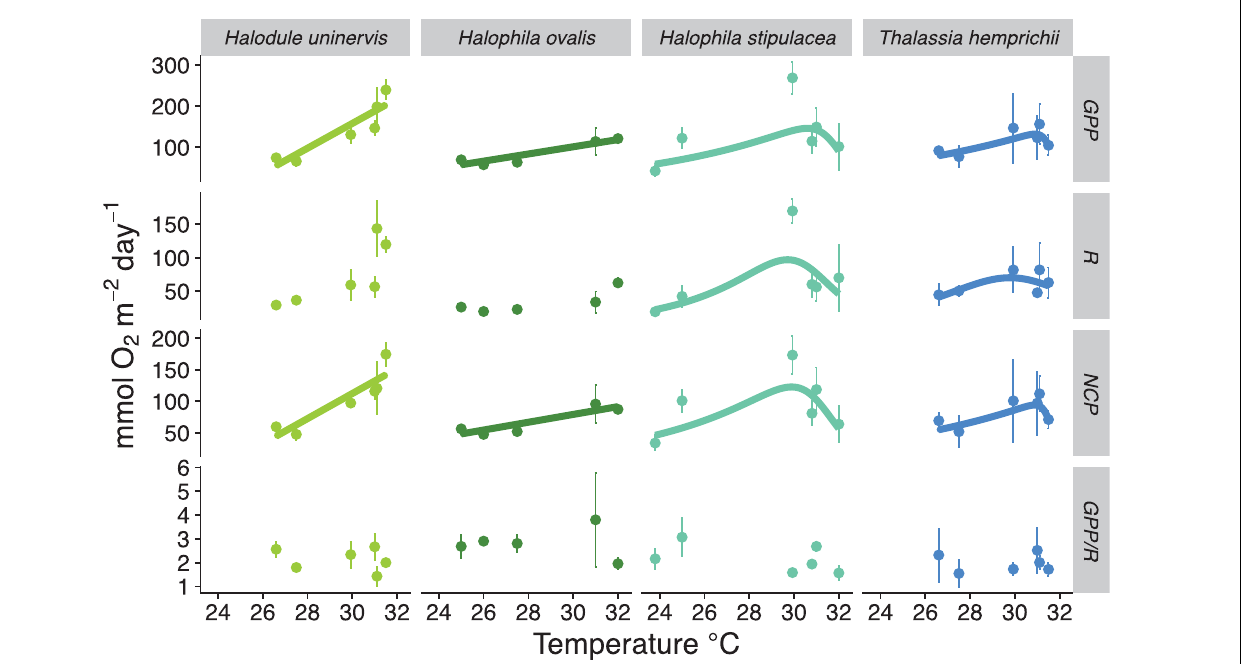
was 2.43 ± 0.57, 0.18 ± 0.05, and 438 ± 515, respectively ( Supplementary Table S2